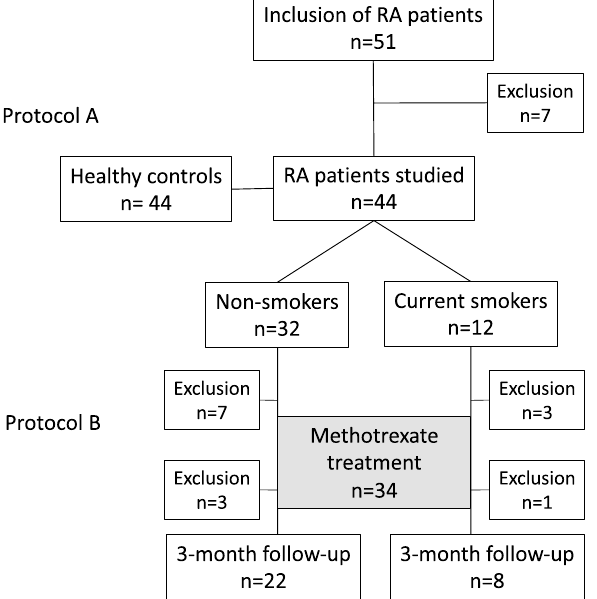
Figure 1. Flowchart of included and excluded patients in protocol A and B of the